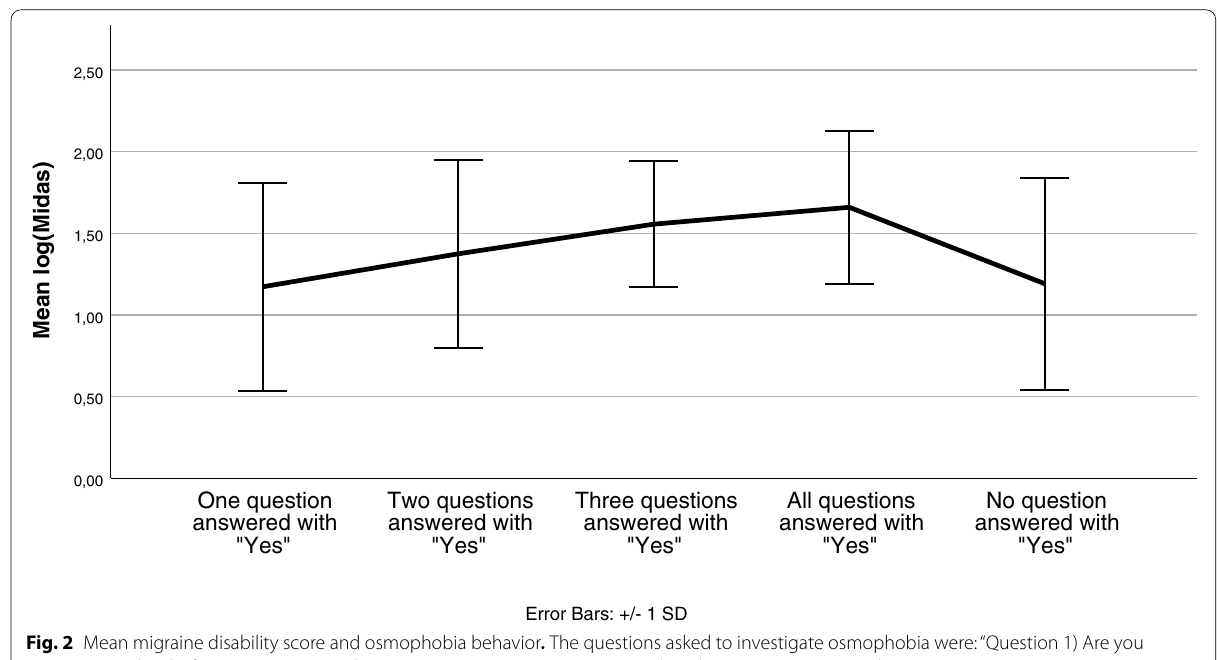
Fig. 2 Mean migraine disability score and osmophobia behavior . The questions asked to investigate osmophobia were: “Question 1) Are you sensitive to odors before a migraine attack?”, “Question 2) Are you sensitive to odors during a migraine attack?”, “Question 3) Are you sensitive to odors on days without migraine?” and “Question 4) Can odors trigger migraine attacks in